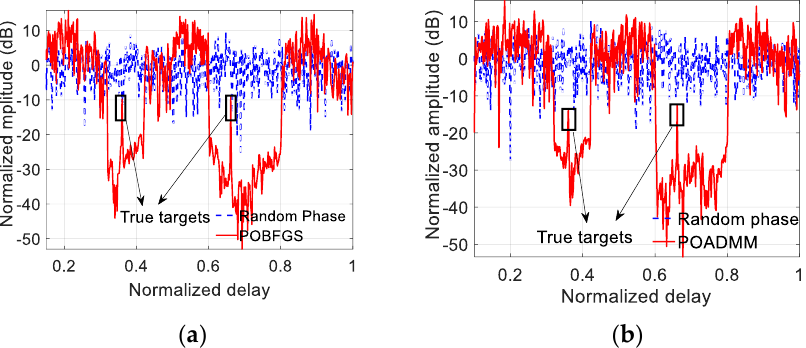
Figure 8. The effect of resisting the RDJ using different methods. ( a ) The result of POBFGS without the constraint of global PAPR. ( b ) The result of POADMM with the constraint of global PAPR.